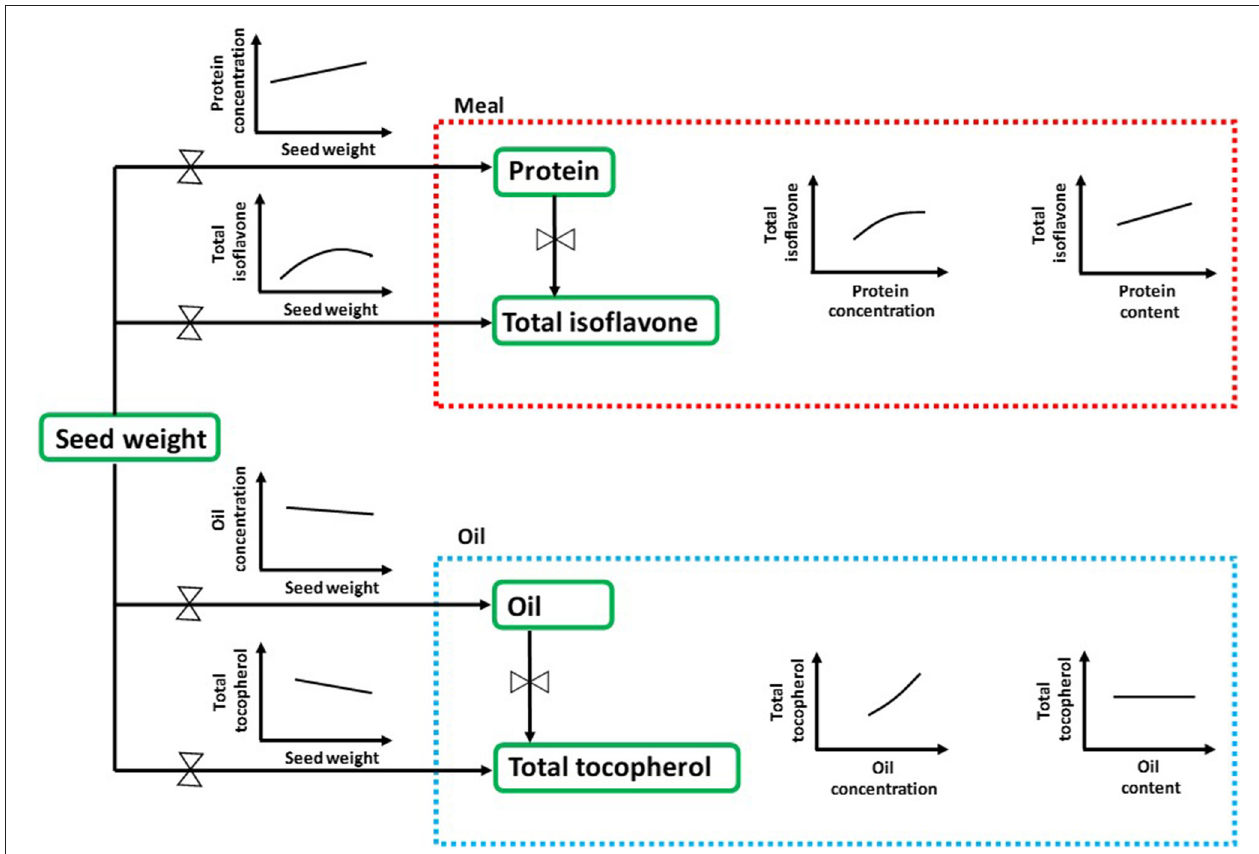
FIGURE 4 | Comprehensive scheme of quality matrix highlighting the main interrelationships between seed nutraceuticals in soybean with the major seed components concentrations and contents through an ecophysiological perspective. Protein and oil concentrations are expressed as percentage of dry weight, whereas contents are expressed as mg component per seed on a dry basis. Total isoflavone and total tocopherol contents are expressed as mg and µ g component per seed on a dry basis,